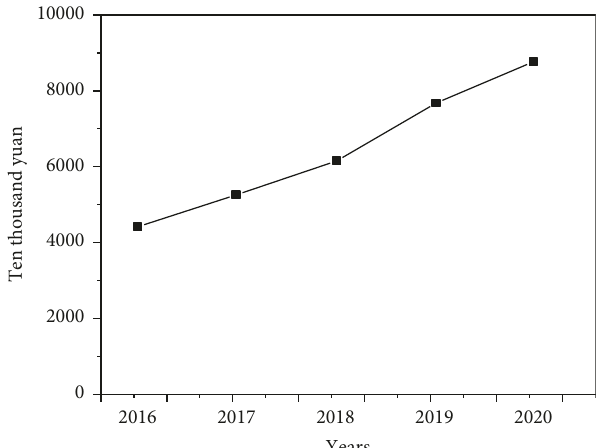
Figure 11: Operating profit of CW company from 2016 to